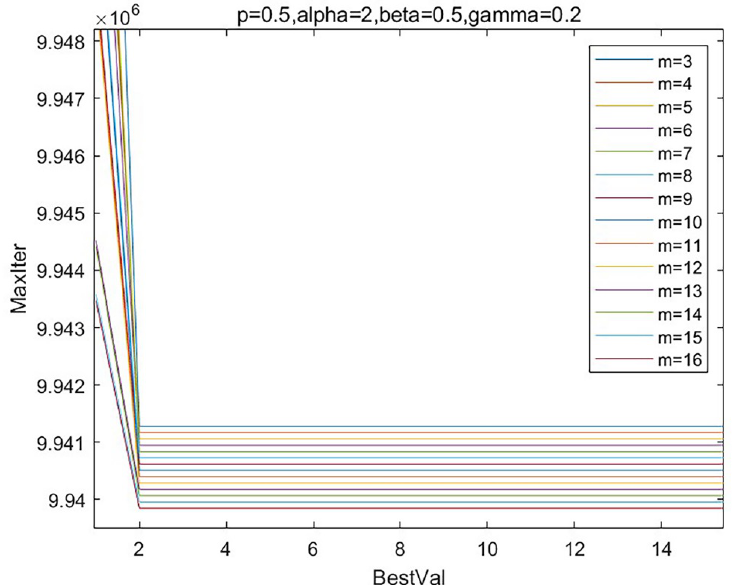
Fig. 3 The relationship map between defender loss and attacker rationality p of 0.5 and site selection facilities